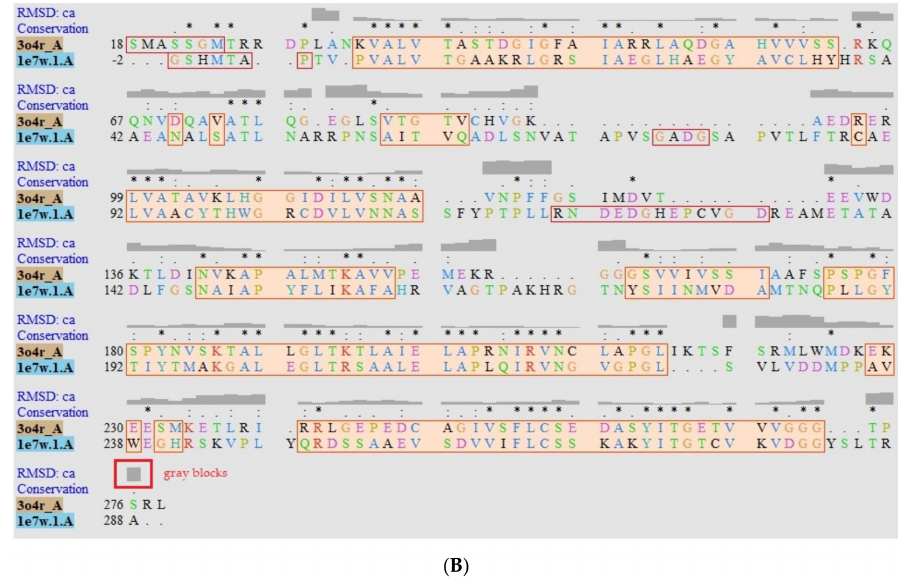
Figure A2. Structural Models of PTR1 (1E7W) and DHR (3O4R) targets. ( A ) Overlapping of Leishmania (sky blue) and H. sapiens (salmon) enzymes. Green zones indicate position of interest in humans. ( B ) Alignment sequence. The aligned regions are indicated in the colored boxes, root mean square deviation (RMSD) as gray blocks, “*” identical or preserved residues; “:” Preserved substitutions and “.” Semi-preserved substitutions.